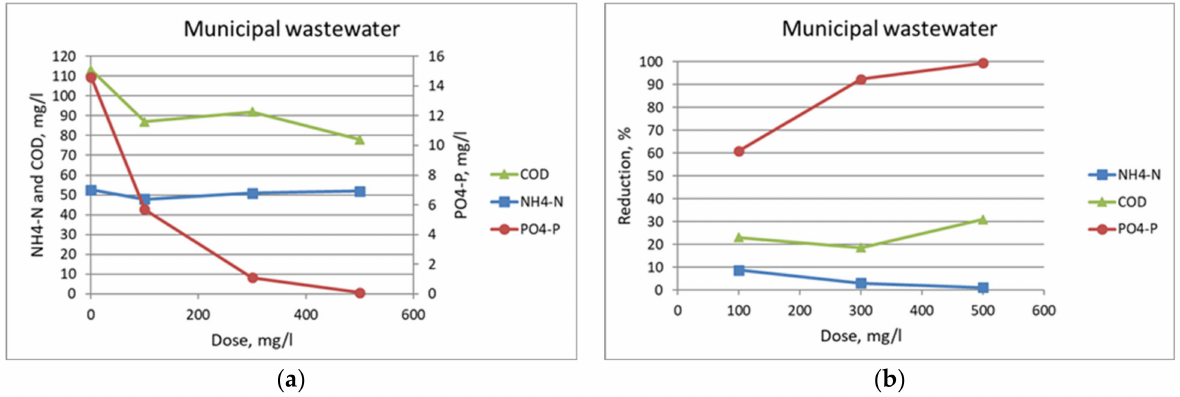
Figure 7. Effect of Ca(OH) 2 dose on the concentrations ( a ) and reductions ( b ) of NH 4 -N, PO 4 -P, and COD for the municipal wastewater sample at laboratory scale